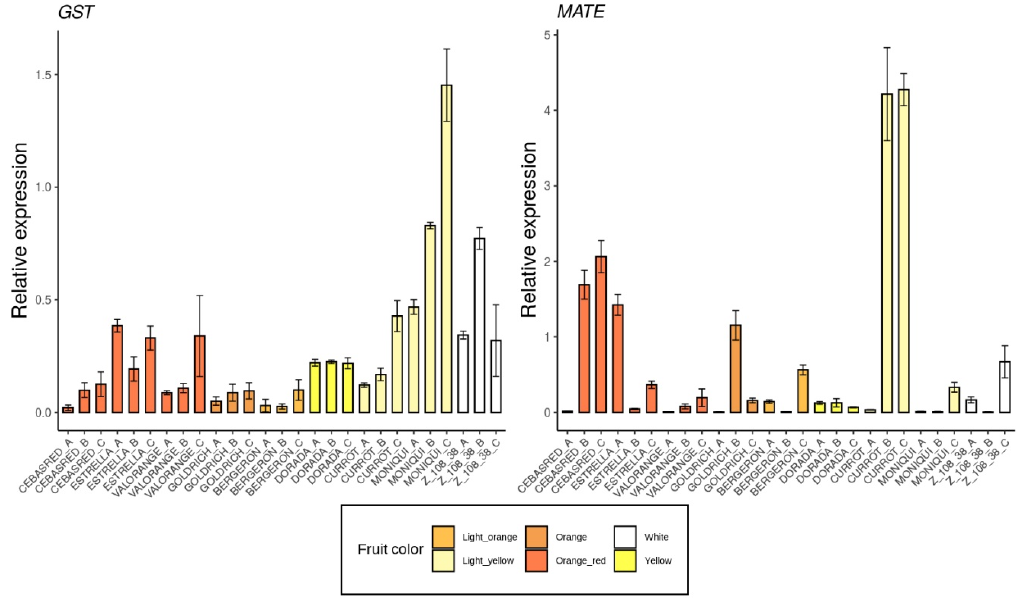
Figure 7. Expression dynamics barplots of the genes described as metabolites transporters GST and MATE , in the nine cultivars ‘Bergeron’, ‘Cebasred’, ‘Currot’, ‘Dorada’, ‘Estrella’, ‘Goldrich’, ‘Moniquí’, ‘Valorange’ and ‘Z 108-38 ′ at three different ripening stages based on their skin ground color and firmness: green fruit (_A), during color change (_B) and at physiological ripening (_C).